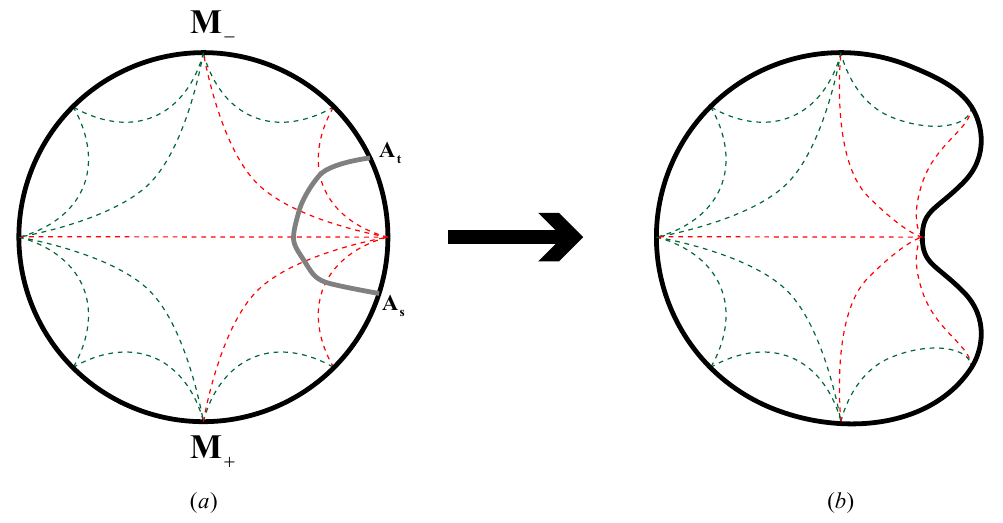
Figure 11 . Removing the entanglement connecting a certain elementary region A s in M + with another elementary region A t in M − , the area of the RT surfaces that intersect with thread bundle ~v st will accordingly decrease by a value of F st . The removed thread bundle is marked as a thick grey line, and the affected RT surfaces are marked as red dashed